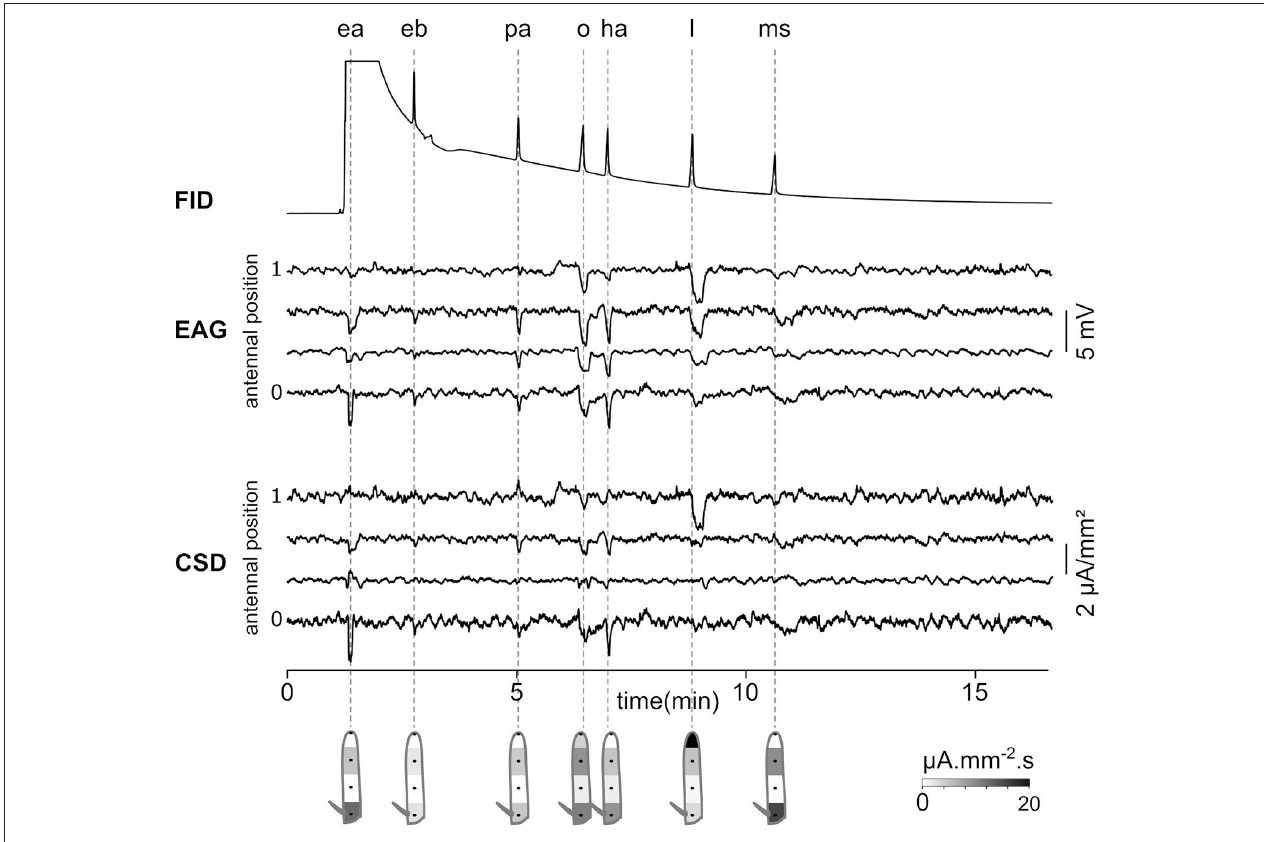
FIGURE 8 | Gas-chromatography coupled with an EAD-CSD. Top: Flame ionization detector (FID) signal recorded at the output of the gas-chromatograph injected with a 10 − 3 dilution of seven compounds in hexane. The compounds are ethyl acetate (ea), ethyl butyrate (eb), pentyl acetate (pa), 1-octen-3-ol (o), Z3-hexenyl acetate (ha), linalool (l), and methyl salicylate (ms). Times of peaks are indicated with dashed lines. Ethyl acetate was ejected at the same time as hexane, and therefore the peak is not visible in the FID signal. Middle: EAG was recorded at four positions of the funiculus of a Z. cucurbitae female. Bottom: the CSD response was estimated from EAG recordings. Under each response, the spatial maps were drawn from a temporal integration of CSD